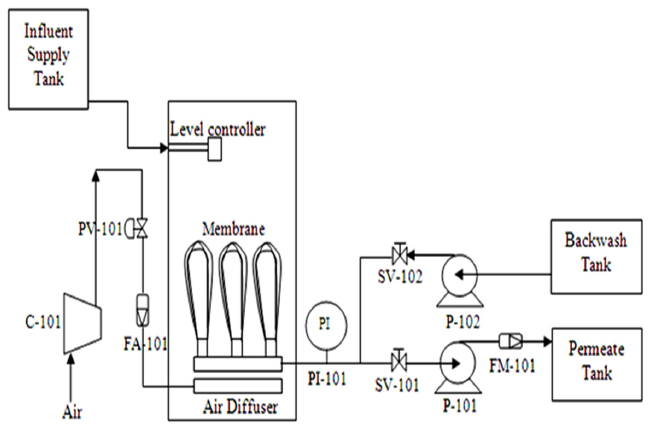
Figure 1. Schematic diagram of the submerged MBR (SMBR) system. Table 1. List of instruments in the pilot plant. Tag No.